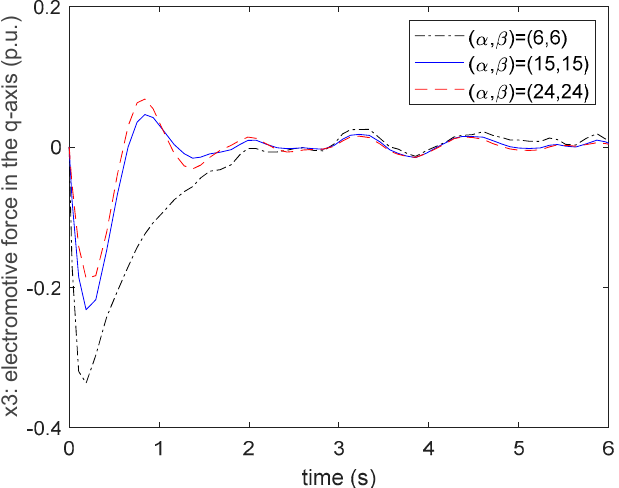
Figure 11. The comparisons of state ( )